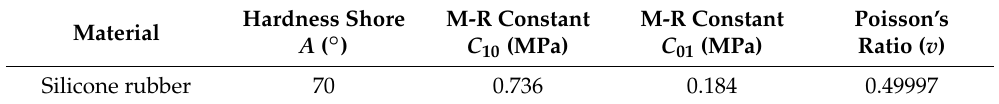
Table 5. Mechanical properties of the silicon rubber material.